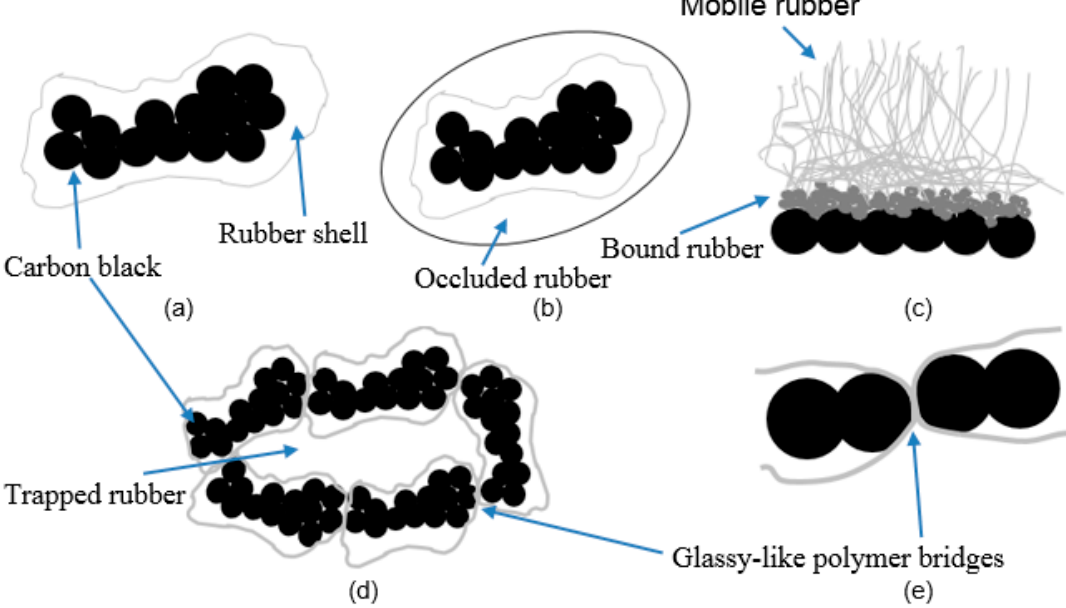
Figure 1. Models of filler–rubber interaction mechanisms and behavior of rubber: ( a ) strongly bound rubber around the carbon black; ( b ) occluded rubber around the rubber shell; ( c ) bound rubber near the carbon black (CB), transition layer, and then the mobile rubber far from the CB surface; ( d ) CB agglomerate and trapped rubber in between the aggregates; ( e ) filler aggregates are bound through glassy-like polymer bridges [18,19,24].